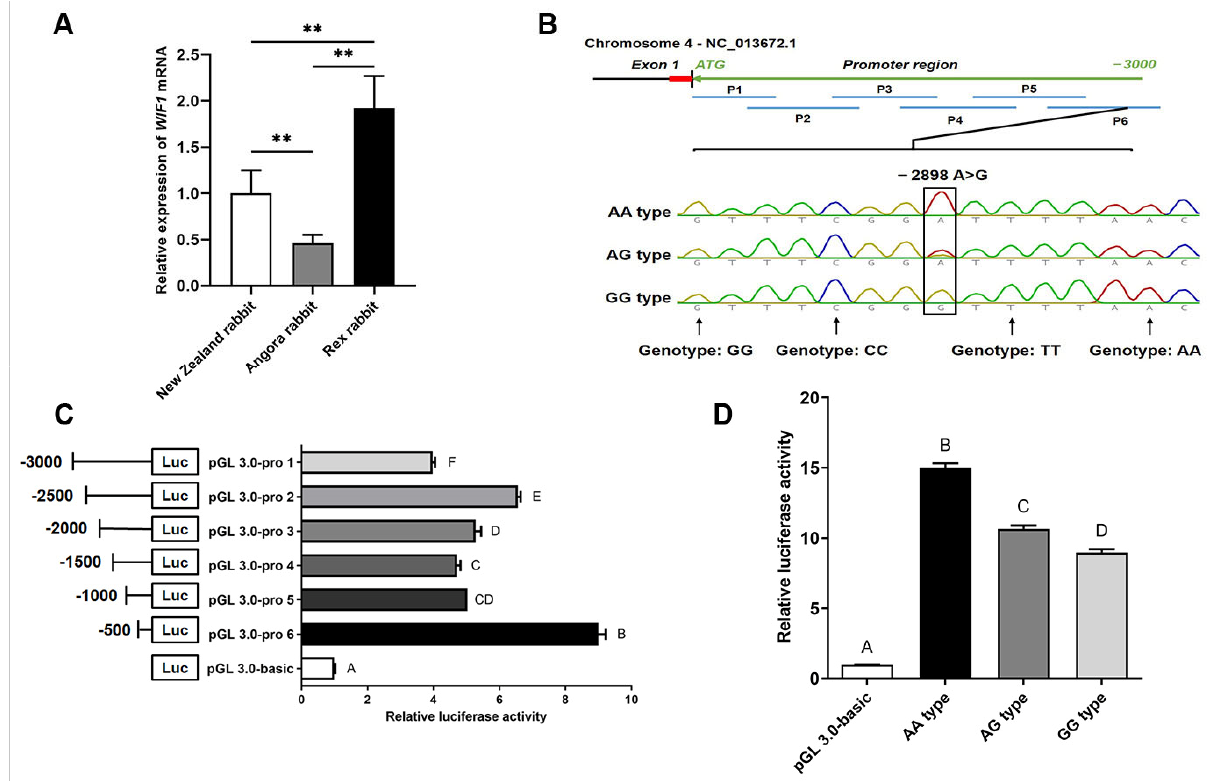
Figure 2. A single nucleotide polymorphism in the promoter region regulated the WIF1 gene expression in different rabbit breeds. ( A ) The mRNA relative expression level of the WIF1 gene among the Rex, New Zealand, and Angora rabbits. ( B ) The detection of single nucleotide polymorphism in the WIF1 promoter region. ( C ) The detection of luciferase activity of the WIF1 promoter region. ( D ) The analysis of luciferase activity of the different genotypes (AA, AG, and GG) in the WIF1 core promoter region. ** p < 0.05, values indicated with different letters (ABC) are significantly different. p < 0.05.